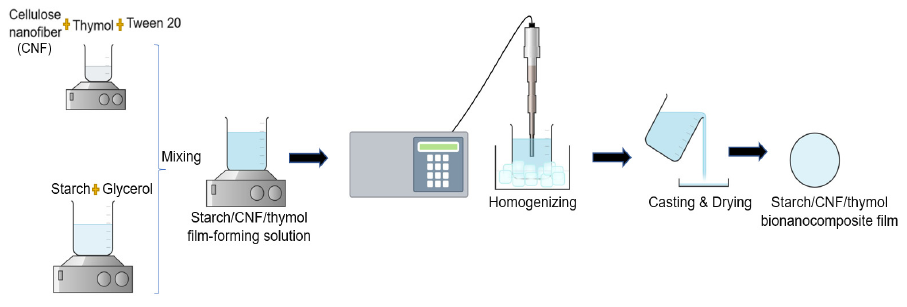
Figure 1. Schematic diagram of the film preparation